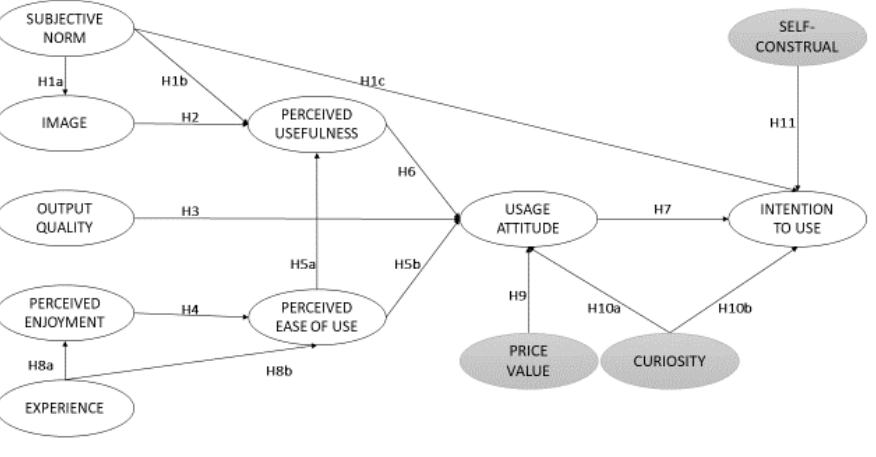
Figure 1. Research Figure 1. Research model.